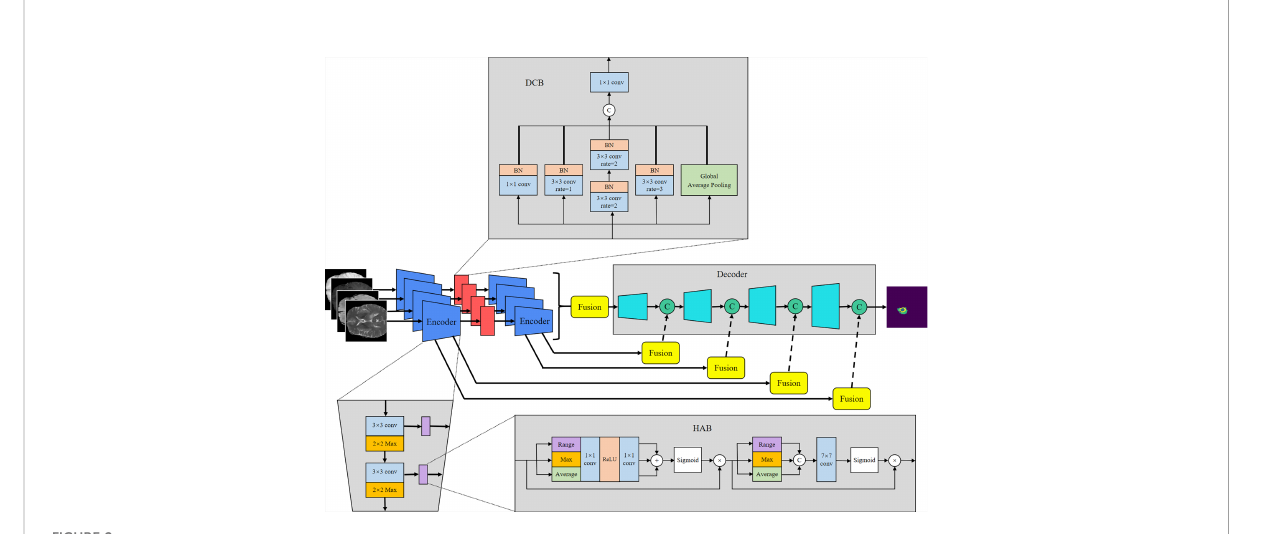
FIGURE 2 Proposed MM-UNet network